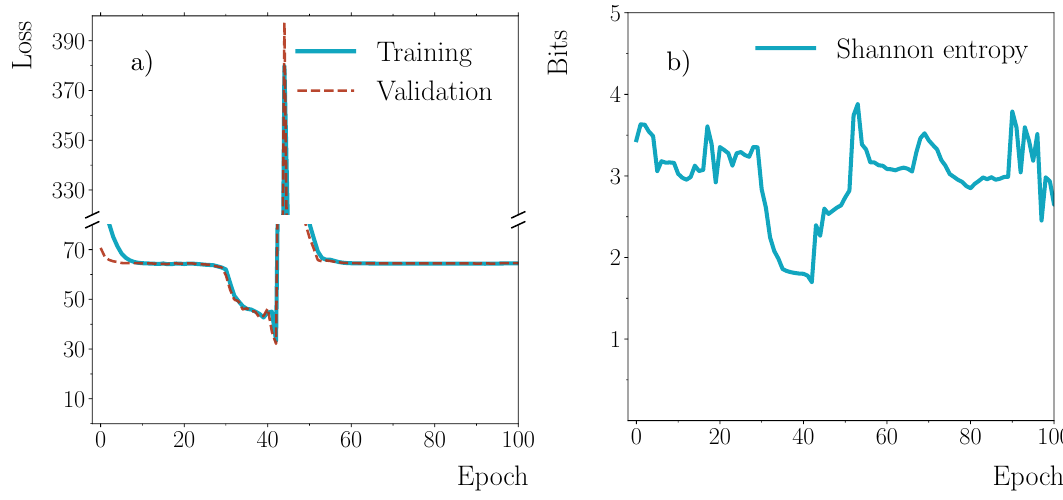
Figure 3 . Evolution of the model during training. a), left, shows how the loss function evaluated on the training and validation event samples changes during training, while b), right, shows the evolution of the Shannon entropy of the FilterMask